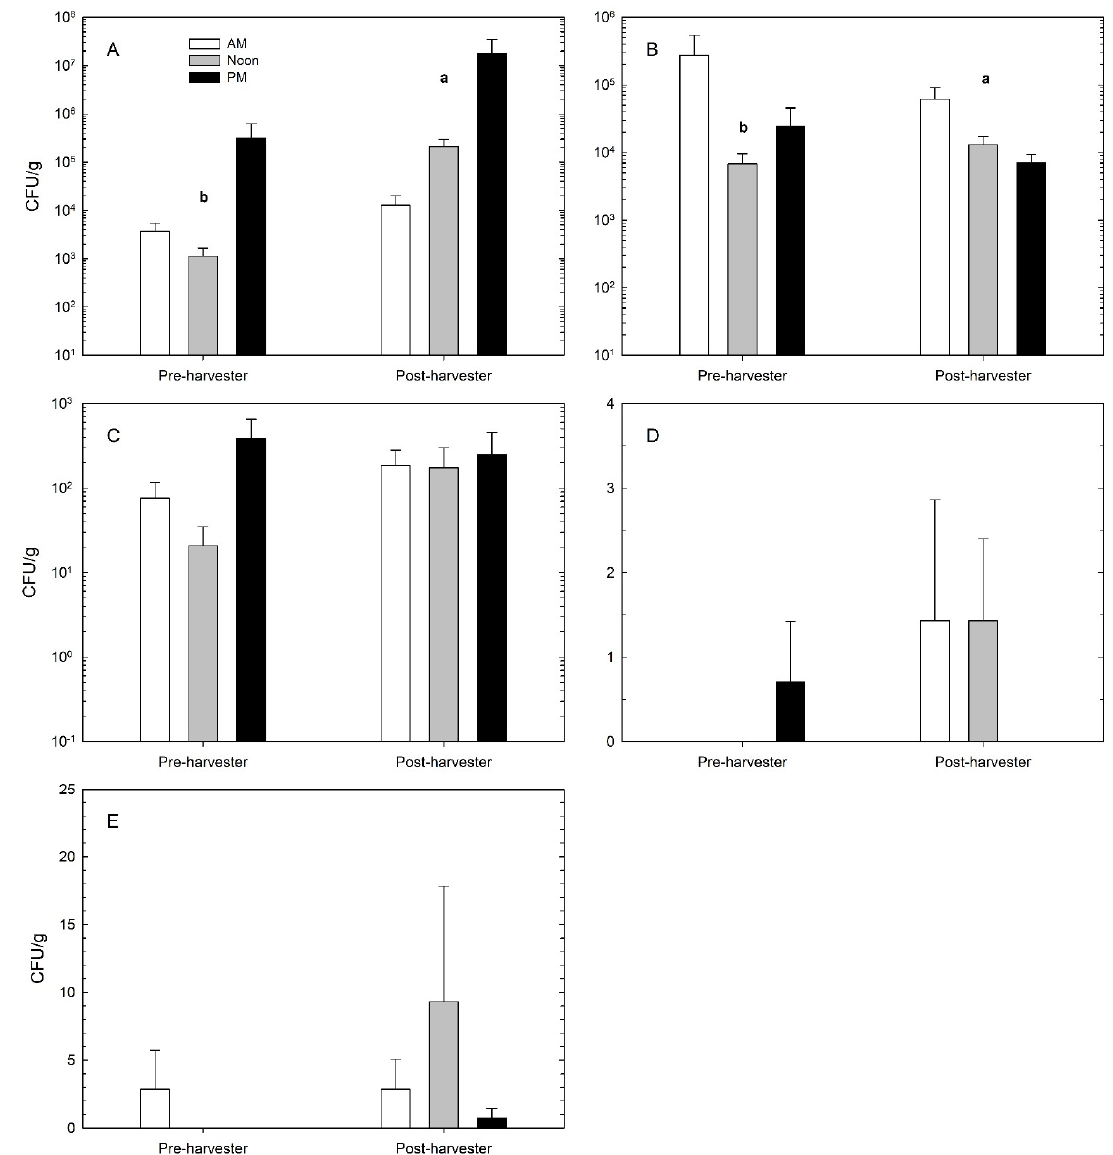
Figure 3. Microbial loads on fruit from blueberry mechanical harvesters in the field when sampled in the morning (AM), at noon, and in the evening (PM). Fruit were collected either just before the plant entered the tunnel of the harvester (pre-harvester) or from the berry lug immediately after the fruit had travelled through the harvester (post-harvester). ( A ) Total aerobes, ( B ) total yeasts and molds, ( C ) coliforms, ( D ) fecal coliforms, and ( E ) enterococci. Values are means and standard errors across seven harvesters sampled in each of 2 years. Bars with the same lower-case letters are not significantly different for comparison of the sample location main effect (Tukey’s test, p = 0.05). Analysis based on log 10 ( x + 1)-transformed values, untransformed values are shown in the figures. CFU = colony-forming units.